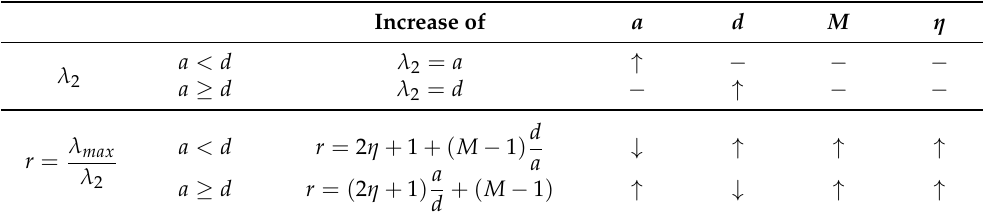
Increase of a d M